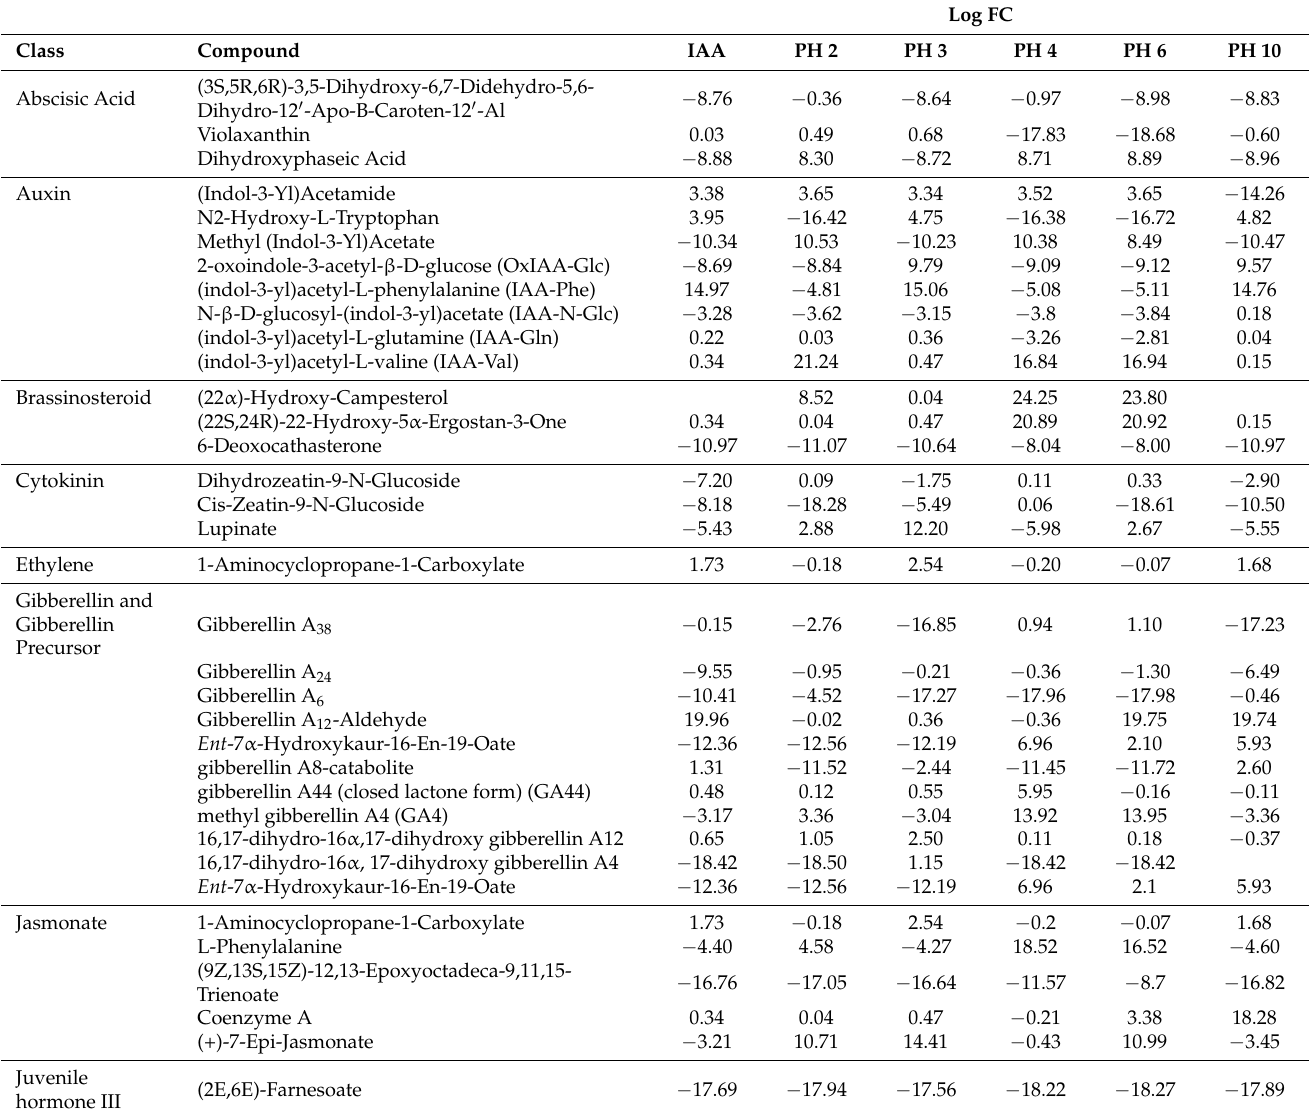
Table 1. The phytohormones modulated by the different protein hydrolysates in leaves of tomato cuttings, as provided by untargeted metabolomics. Compounds are grouped into classes and are provided with individual log fold-change values (Log FC), compared to untreated